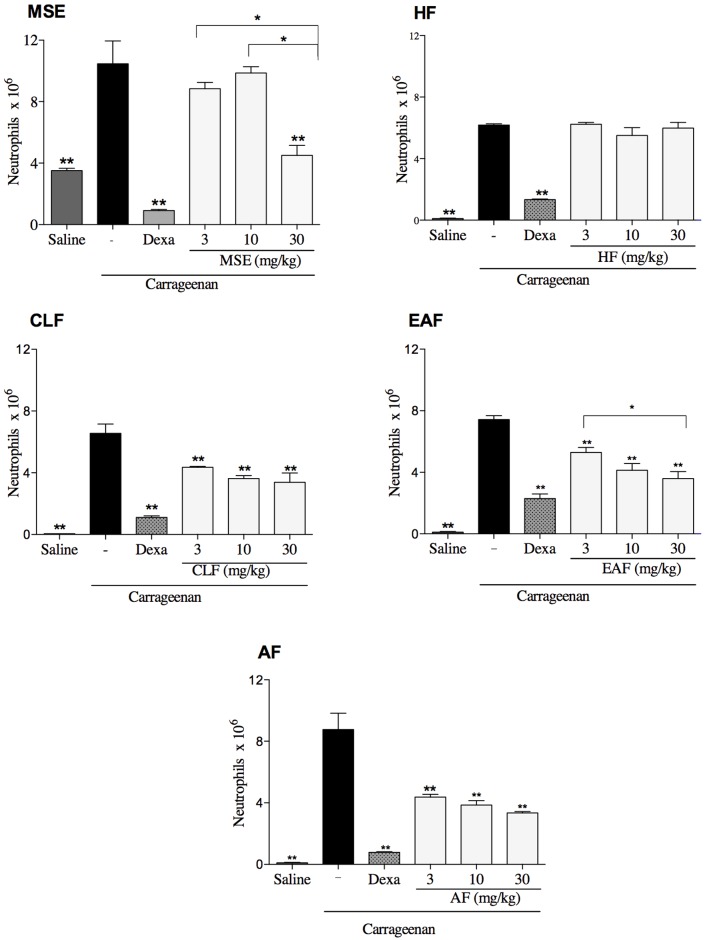
Inhibitory effect of the MSE, HF, CLF, EAF, AF on neutrophil migration into the peritoneal cavity induced by carrageenan. Neutrophil migration was determined 4 h after the injection of carrageenan 500 μg/cavity. Mice previously treated with the vehicle, MSE (ethanol extract of M. sylvestris), HF (hexane fraction), CLF (chloroform fraction), EAF (ethyl acetate fraction) and AF (aqueous fraction). The data are expressed as mean ± SD, n = 6. Symbols indicate statistical difference (p < 0.05, ANOVA, Tukey’s post-test) ** compared to the carrageenan group; * comparison between the concentrations tested of 3, 10 and 30 mg/kg.